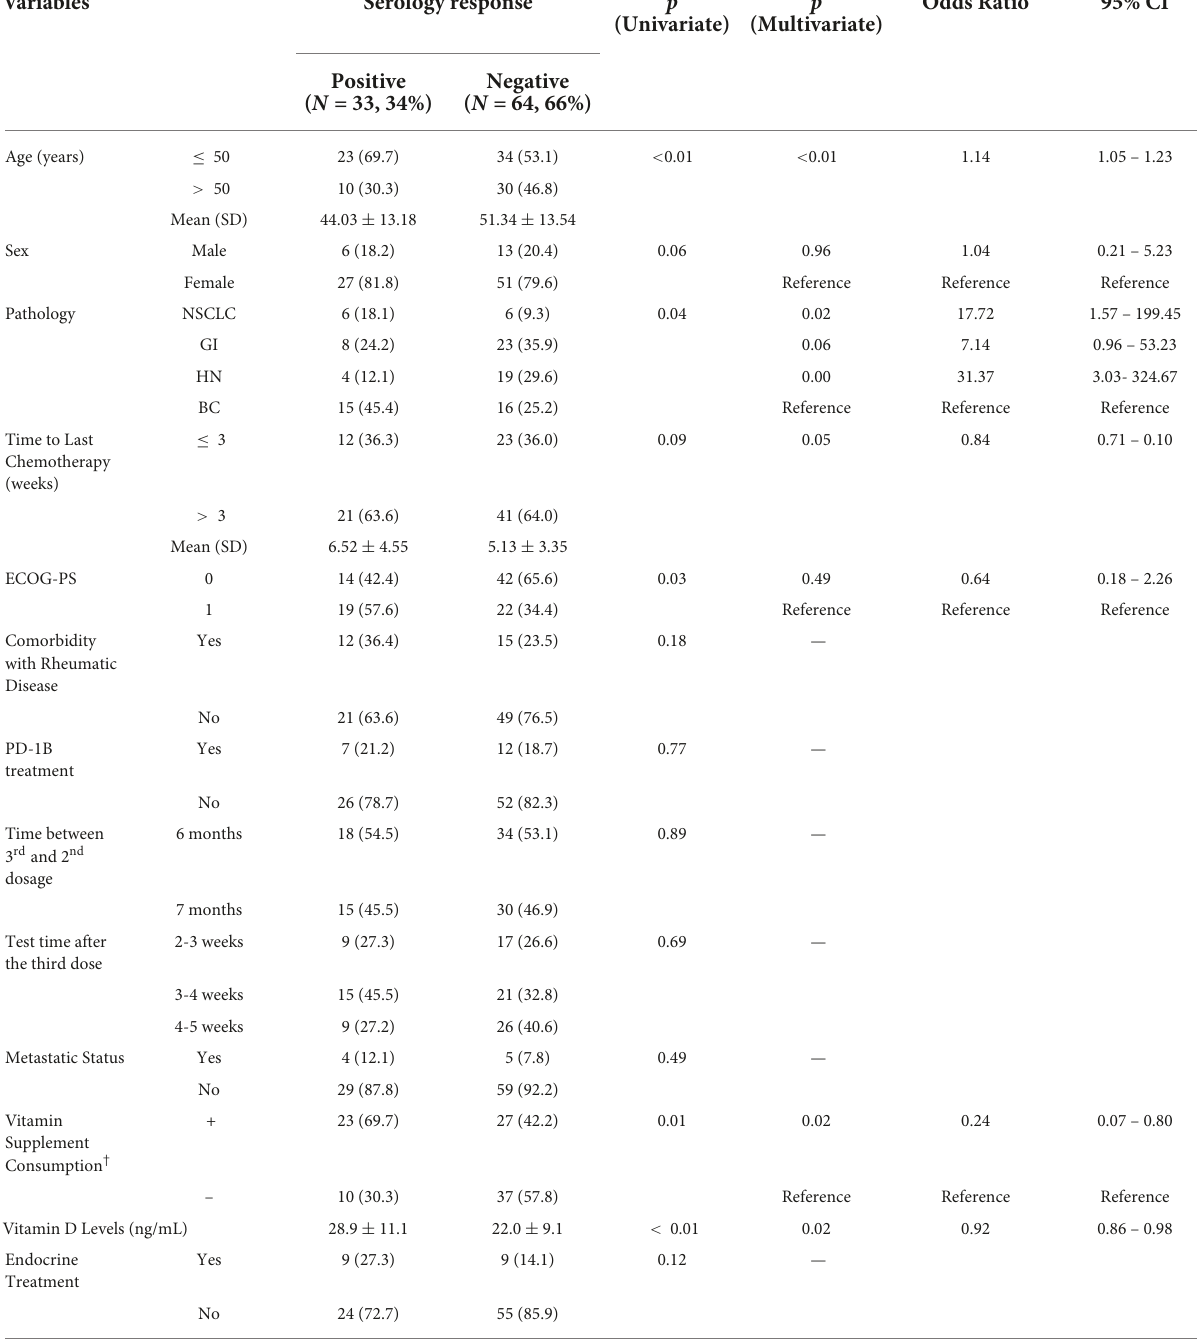
TABLE 2 Univariate and multivariate regression analysis for serology response rate of booster vaccination in SCP-N.